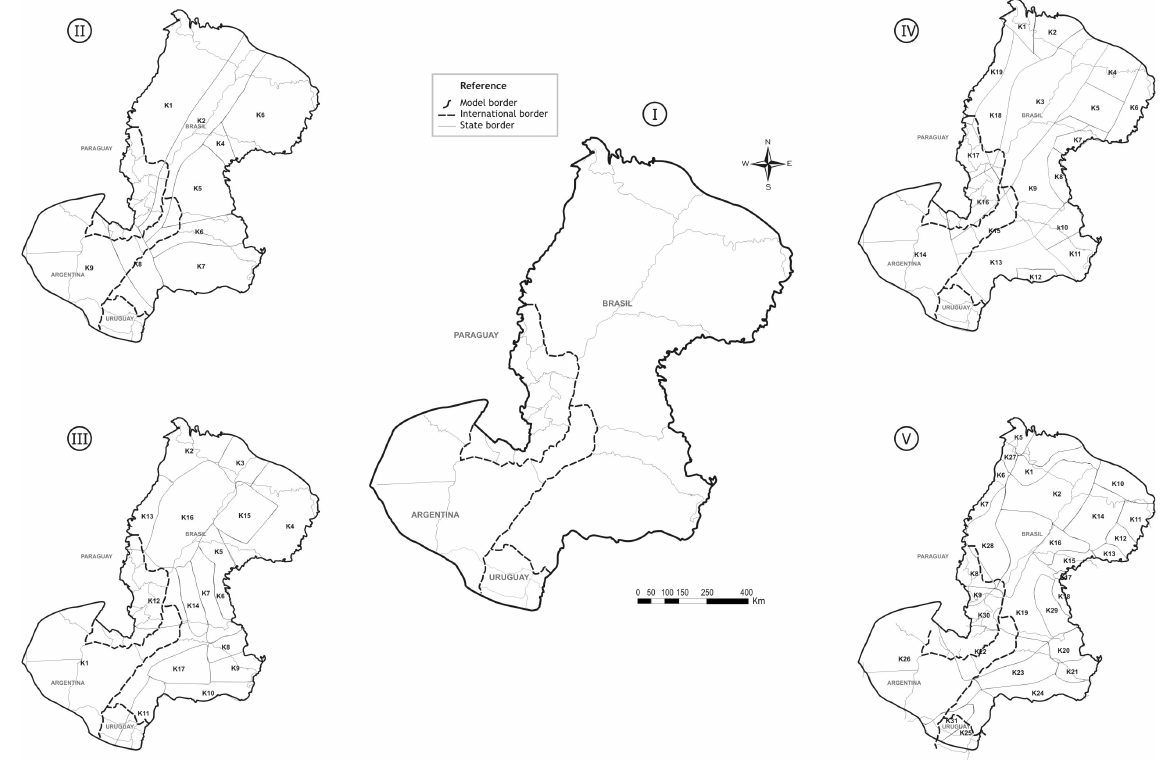
Fig. 3. Alternative conceptual models represented by zonings of hydraulic conductivity.